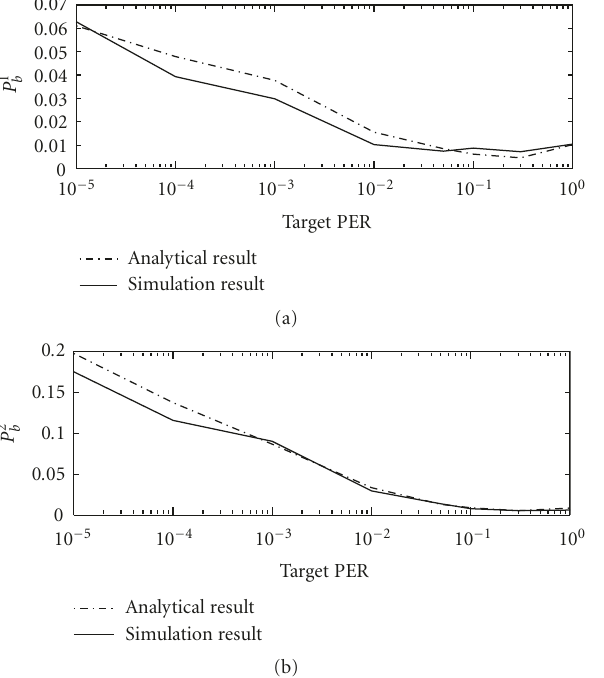
Figure 6: GMDP-based AC policy: analytical and simulated block- ing probabilities as a function of ρ = 10 − 4 . ρ 1